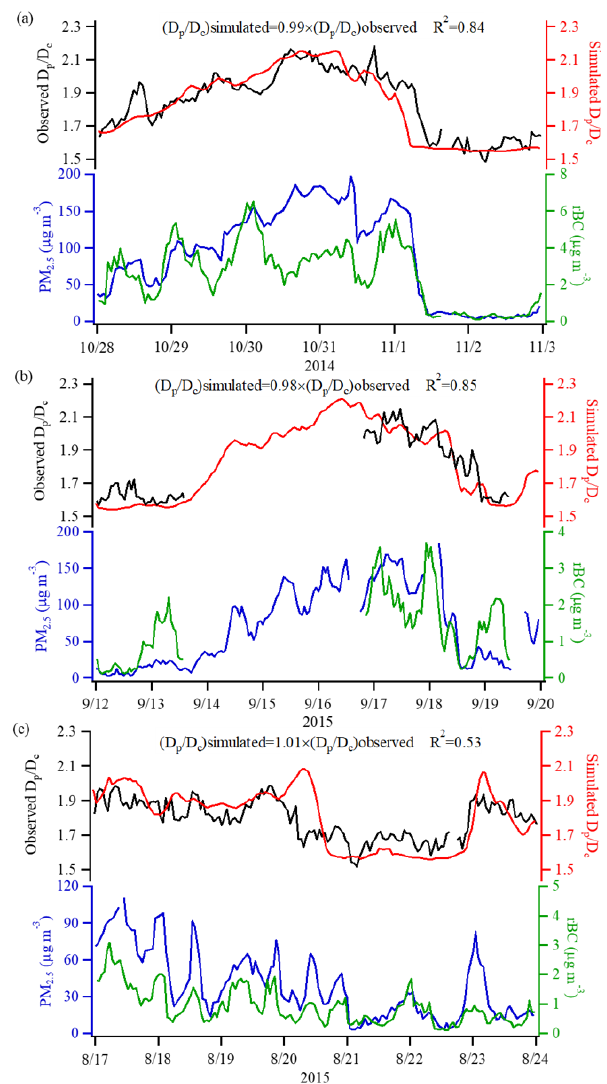
Figure 6. Time series of the observed D p /D c ratio, simulated D p /D c ratio, and PM 2 . 5 and rBC concentrations during the (a) BJOCT2014, (b) BJSEP2015 and (c) BJAUG2015 measurement periods.